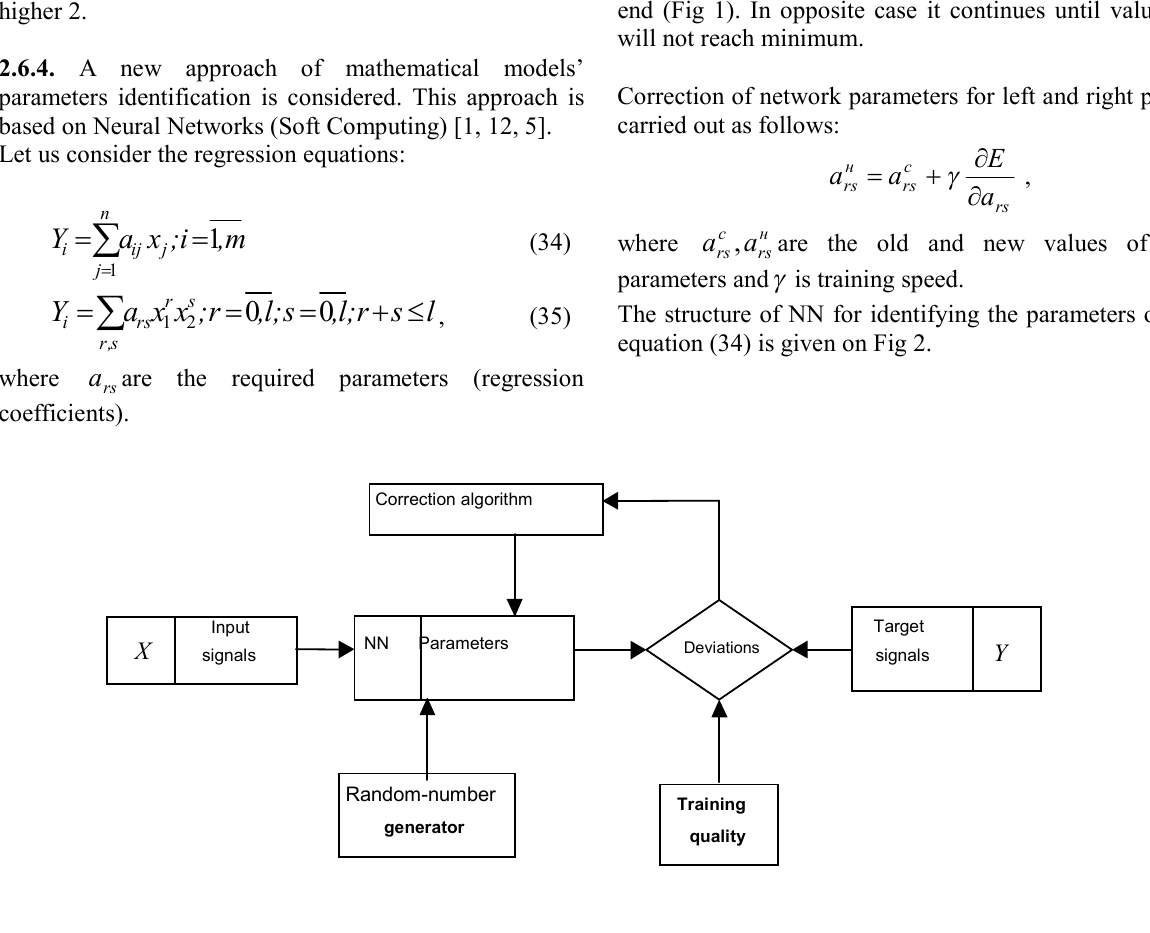
Fig 1. System for network-parameter (weights, threshold) training (with